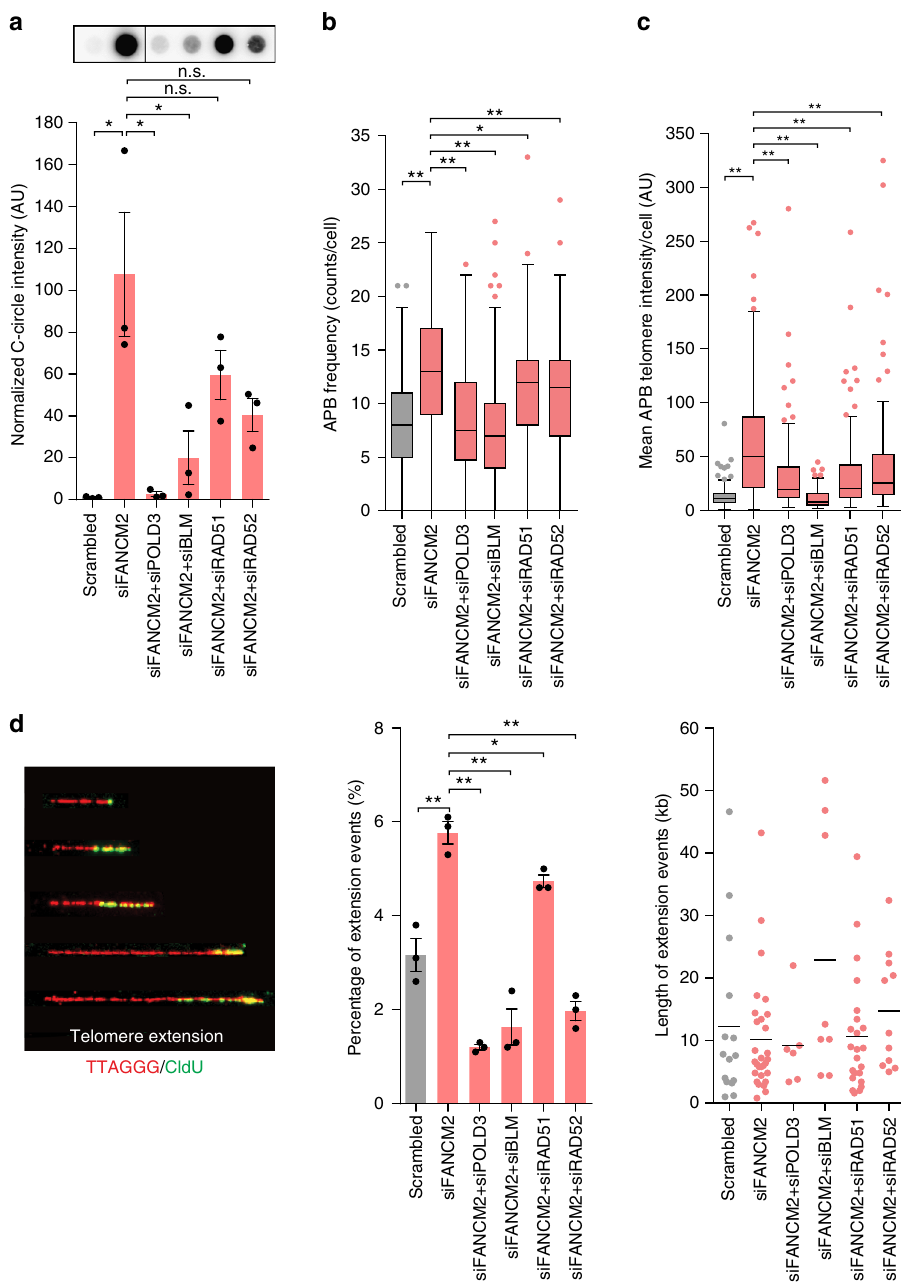
Fig. 3 FANCM depletion results in increased break-induced telomere synthesis. a Representative dot blots and quantitation of C-circles in U-2 OS cells co-depleted of FANCM and either POLD3, BLM, RAD51, or RAD52. C-circles were normalized to the mean of scrambled control. Error bars represent mean ± SEM from n = 3 experiments, * p < 0.05, n.s. = non-signi fi cant, Student ’ s t -test. Quantitations of b APB frequency and c mean APB telomere foci intensity in U-2 OS cells co-depleted of FANCM and either POLD3, BLM, RAD51, or RAD52. Scatterplot bars represent the mean ± SEM. Out of three experiments, n = 150 cells scored per treatment, * p < 0.05, ** p < 0.005, Mann – Whitney test. d Examples of telomere extension fi bers (red) scored after CldU incorporation (green) (left panel). Quantitation of the number and length of telomere extension events in U-2 OS cells co-depleted of FANCM and either POLD3, BLM, RAD51 or RAD52 (center and right panels). Error bars represent mean ± SEM of n ≥ 350 fi bers out of three experiments, * p < 0.05, ** p < 0.005, Student ’ s t